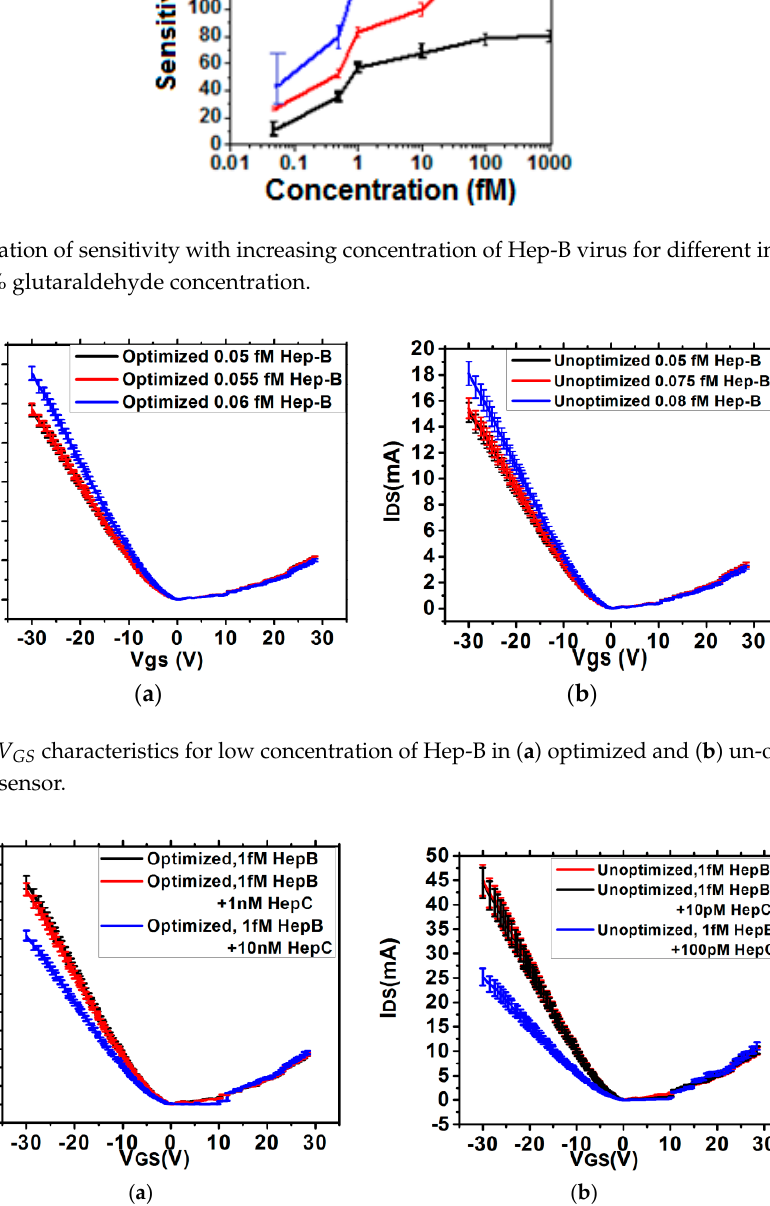
Figure 10. I DS - V GS characteristics for Hep-B and Hep-C mixture in ( a ) optimized and ( b ) un-optimized (24 h treated) sensor.